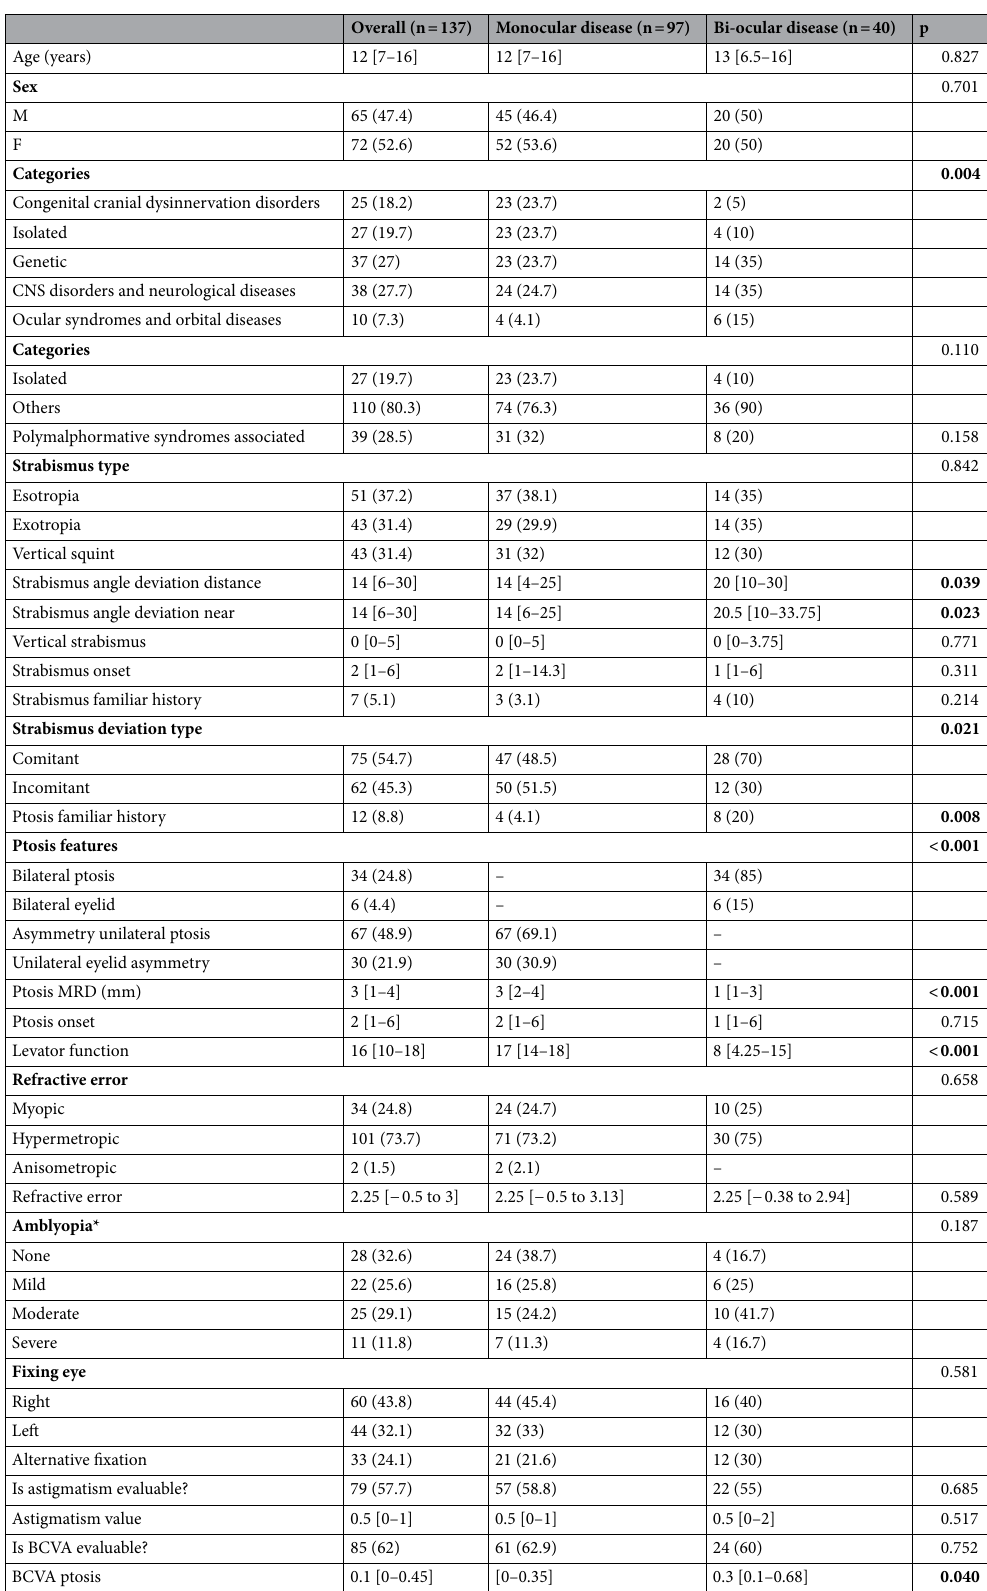
Table 1. General characteristics of the study population (n = 137). M male, F female, CNS central nervous system, MRD margin reflex distance, BCVA best corrected visual acuity. *Others: congenital cranial dysinnervation disorders, Genetic, CNS disorders/neurological diseases, Ocular syndromes/orbital diseases. Significant data are in bold, suggestive p-values in